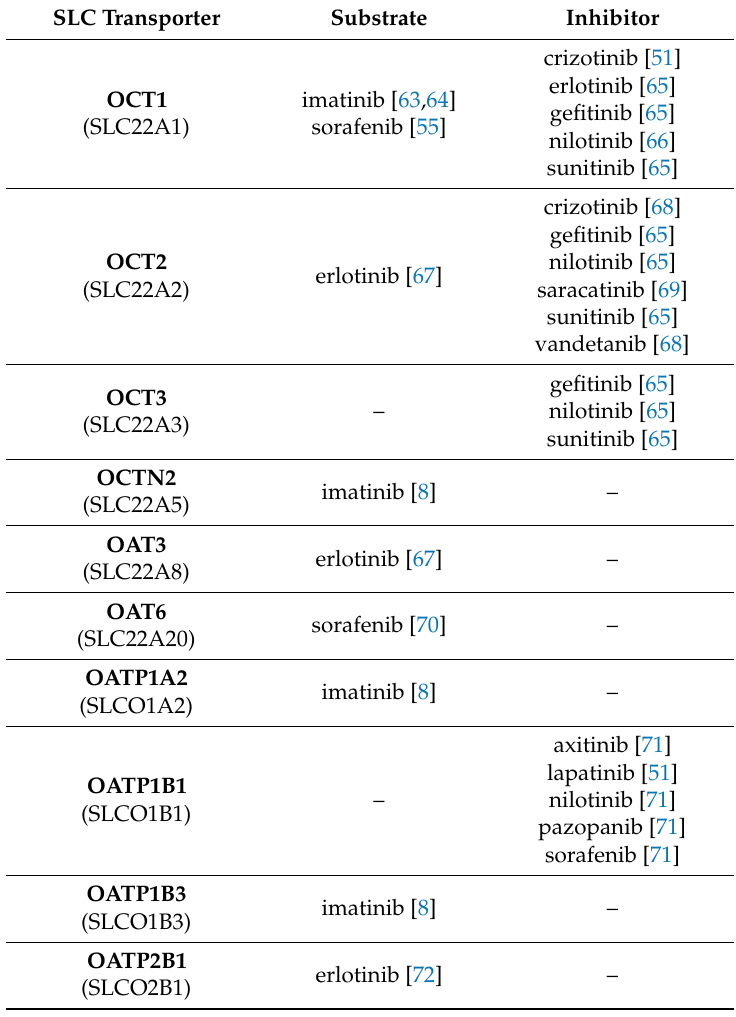
Table 2. Interactions of selected TKIs with SLC